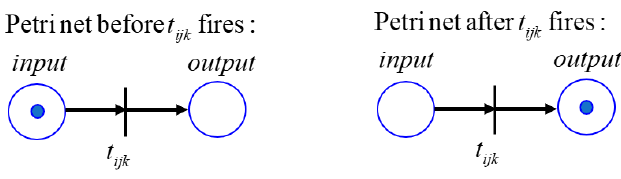
Figure 3. The operation of simple Petri net (PN).